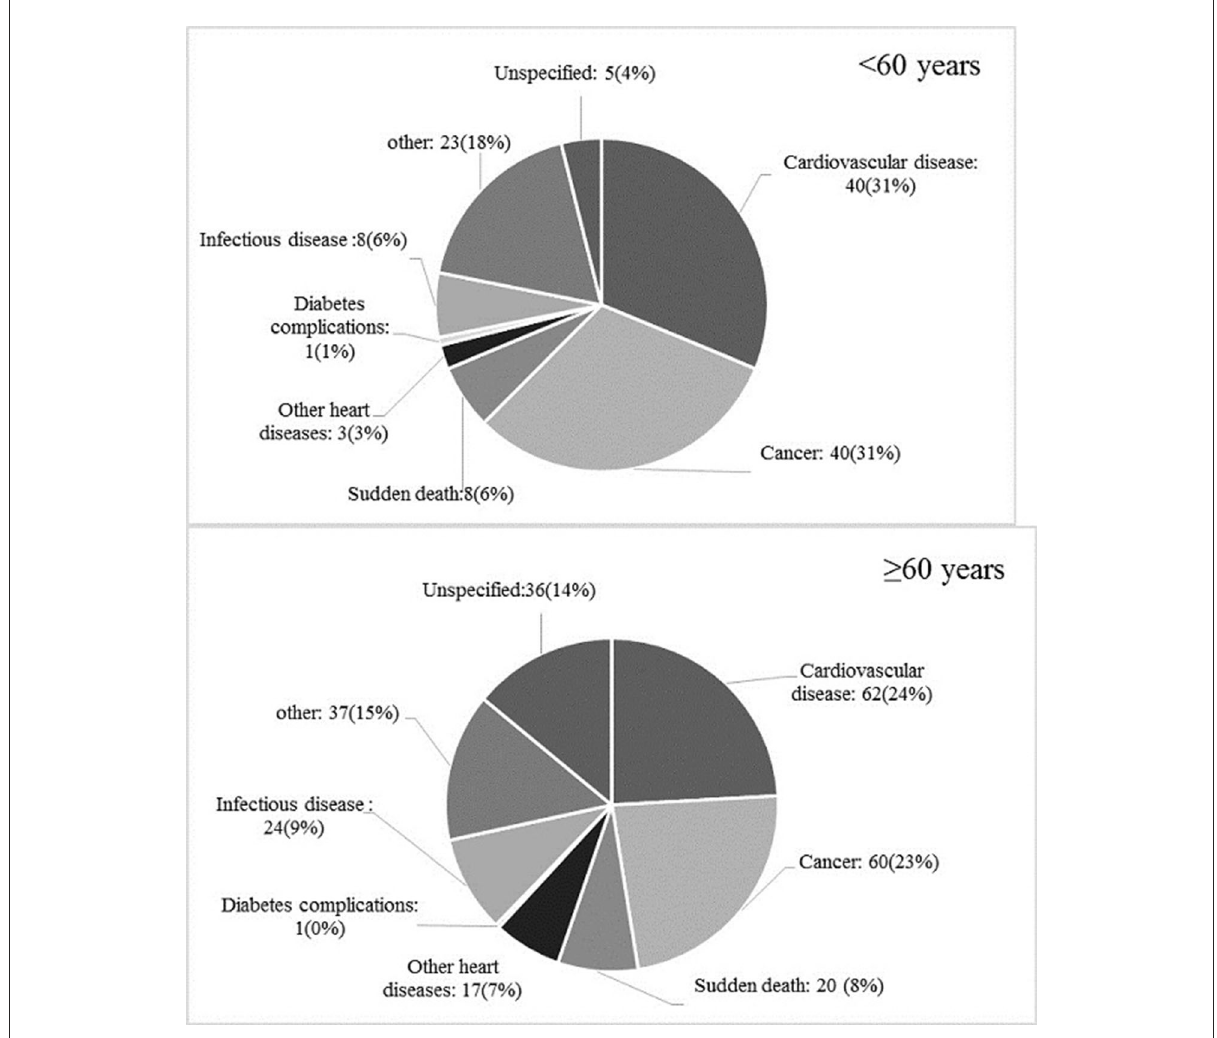
FIGURE3 Age-specific distribution of different causes of total mortality among the study population.